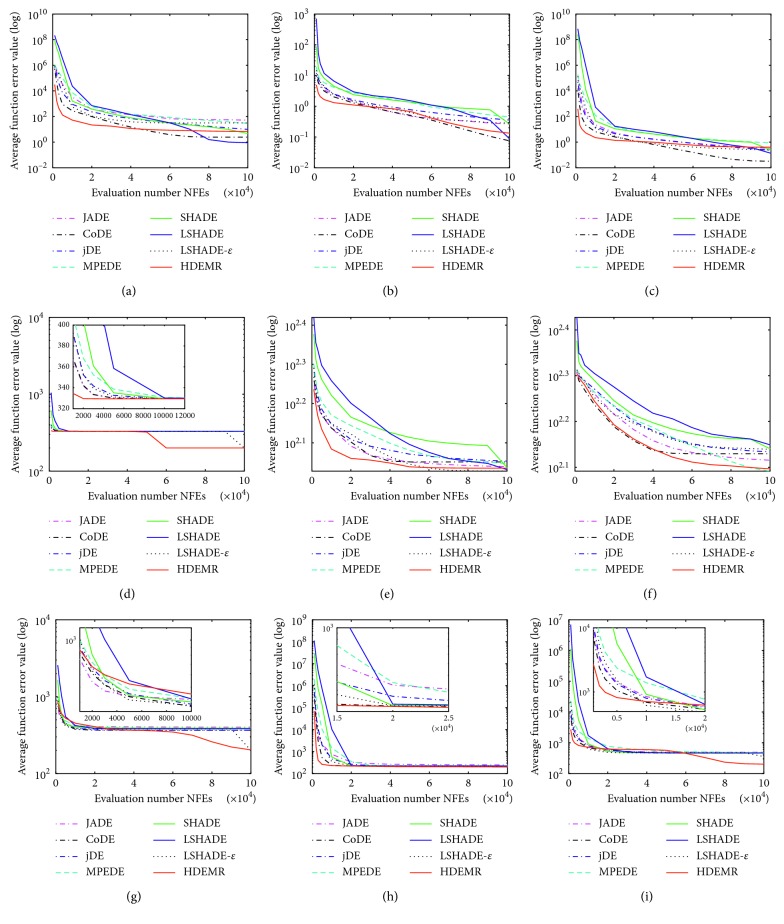
The convergence graphs on different types of CEC2014 benchmark functions. (a) The convergence graph on the hybrid function f17. (b) The convergence graph on the hybrid function f19. (c) The convergence graph on the hybrid function f20. (d) The convergence graph on the composition function f23. (e) The convergence graph on the composition function f24. (f) The convergence graph on the composition function f25. (g) The convergence graph on the composition function f28. (h) The convergence graph on the composition function f29. (i) The convergence graph on the composition function f30.